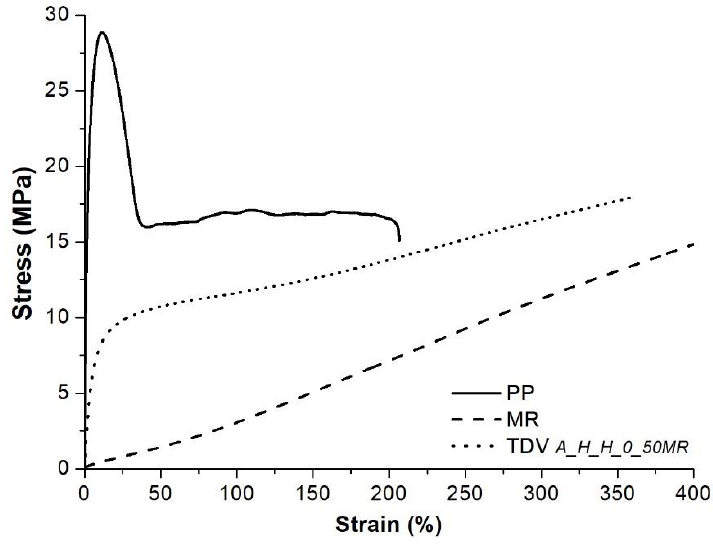
Figure 3. Characteristic tensile curves of the PP, MR, and one of the TDVs.